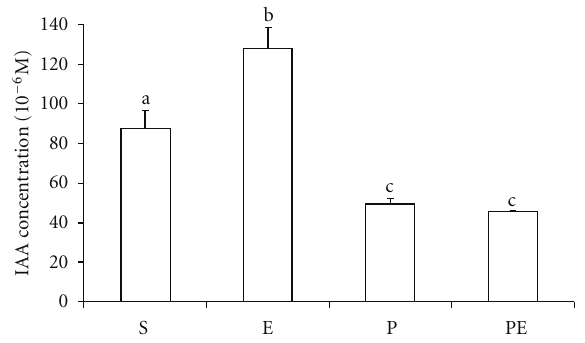
Figure 1: Average IAA concentration at 24, 48, and 72 h by cultivable soil bacteria from soil without macroorganisms (S), with the plant Arabidopsis thaliana (P), with the earthworm Aporrectodea caliginosa (E) and with both plant and earthworms (PE). Means ± s.e., n = 17, di ff erent letters indicate a significant di ff erence, Tukey HSD, P < 0.05.